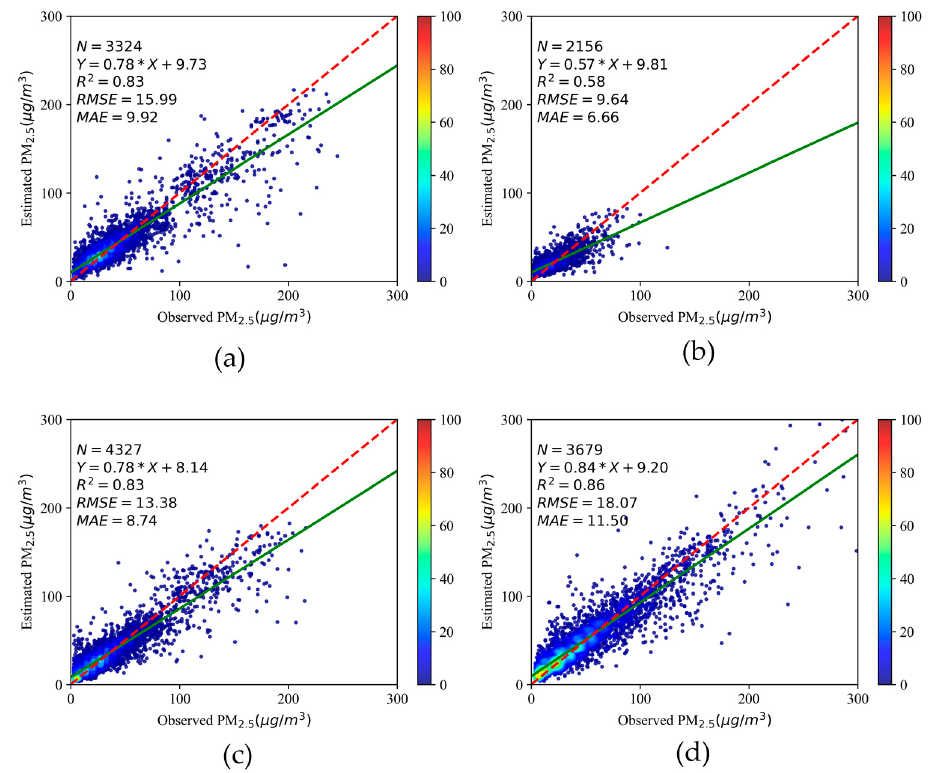
Figure 10. Seasonal model 10-fold, cross-validation scatterplots for the estimated PM 2.5 concentration in 2021. ( a ) Spring; ( b ) Summer; ( c ) Autumn; ( d ) Winter. Red dashed line, 1:1 line; green line, fitted line.